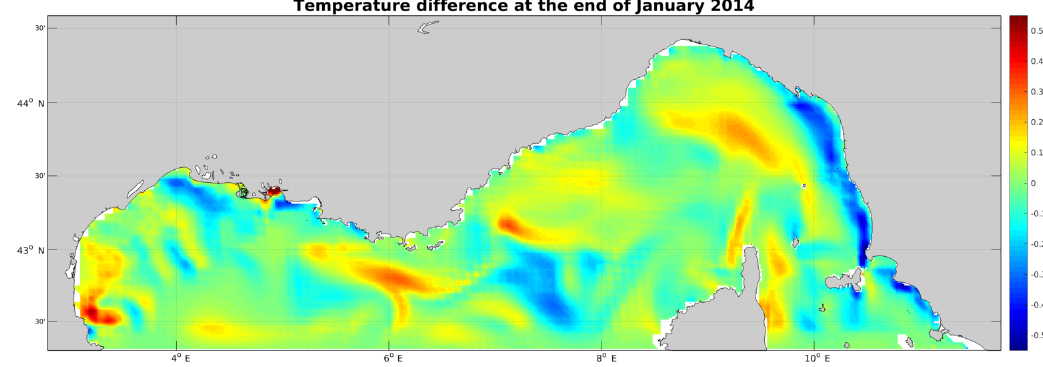
Figure 3. Temperature difference between the parent and nested models on 31 January 2014, projected on the nested-model grid.